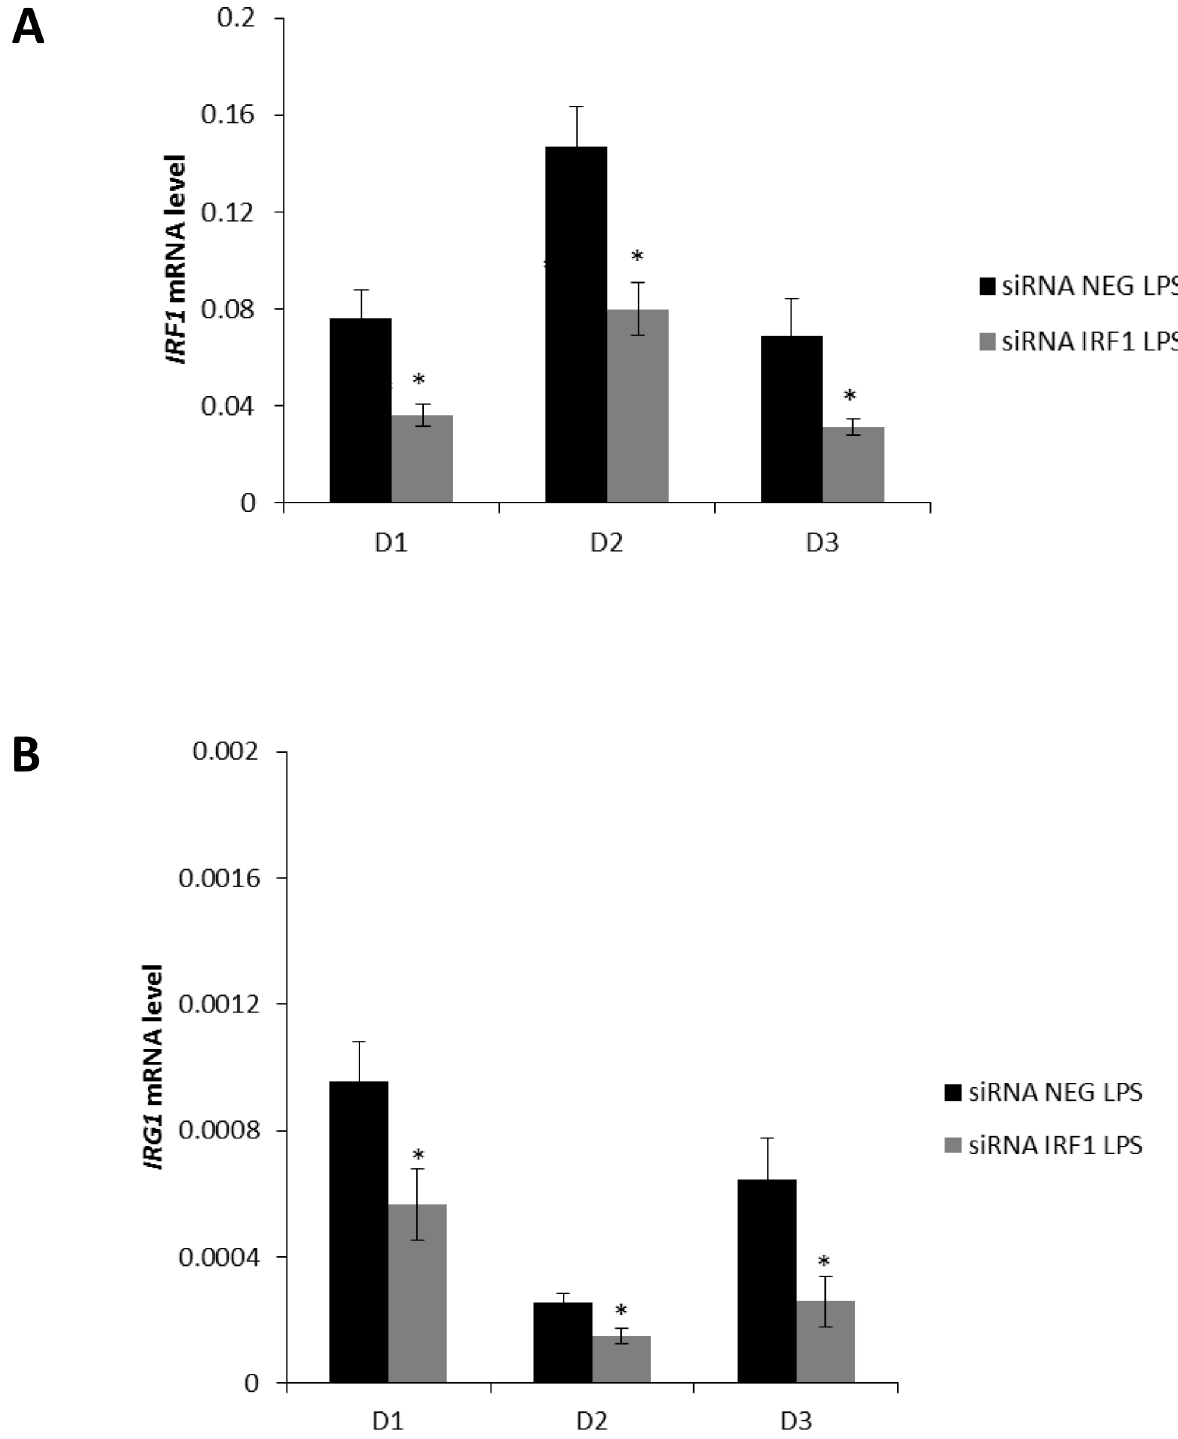
Fig 7. siRNA IRF1 mediated gene silencing in human PBMCs-derived macrophages. PBMCs-derived macrophages were transfected with siRNA negative (siRNA NEG) or siRNA specific to IRF1 (siRNA IRF1) 24 hours before treatment and RNA was extracted 6 hours after activation with LPS (10 μ g/ml) in independent donors (D1-D3). The bars show the mean of ( A ) IRF1 and ( B ) IRG1 mRNA levels of 3 technical replicates ( ± SEM) measured by real-time PCR normalised with L27 as the housekeeping gene. * p < 0.05.